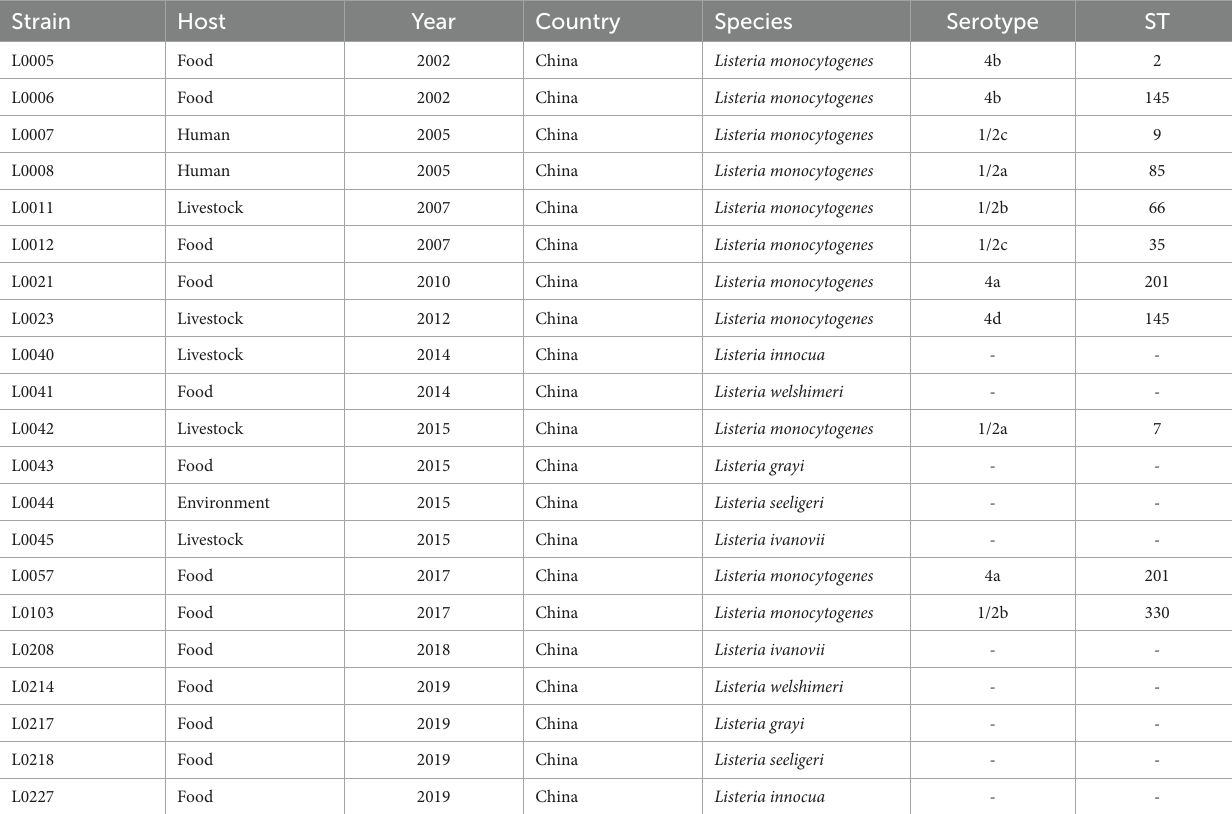
TABLE 1 The examined strains of Listeria species (Lm and non-Lm) with their host, year, country, serotypes, and STs.